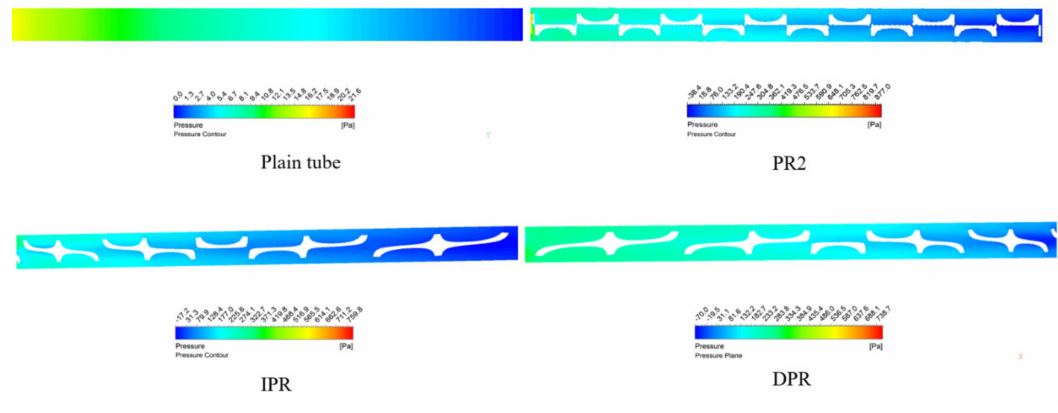
Figure 15. Pressure contours across the